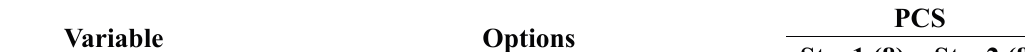
Table 3. Hierarchical multiple regression predicting PCS